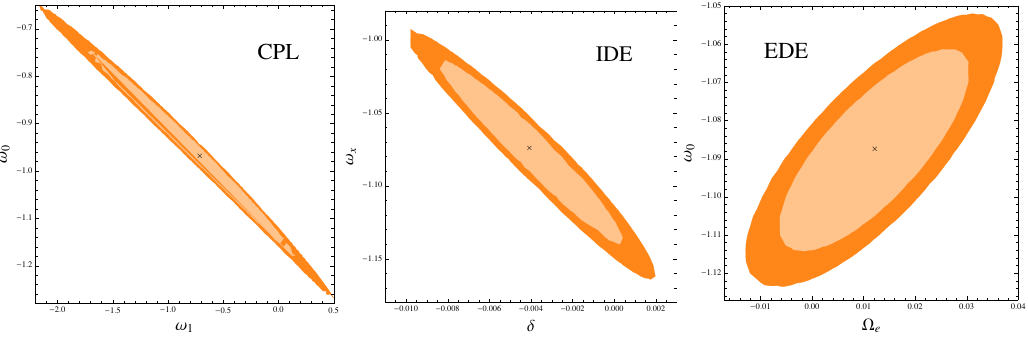
Figure 1. 1 σ and 2 σ two-dimensional CL contours of DE cosmological models discussed, where the main results are shown using the combined analysis (CMB + BAO + SNIa + d A + f gass + SGL).